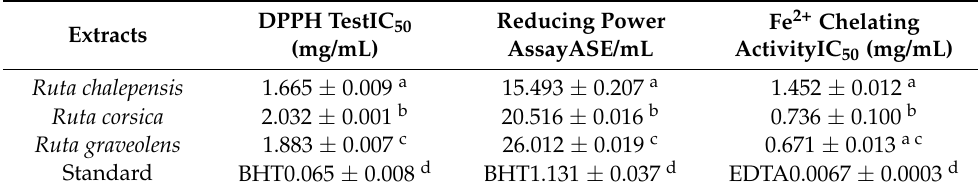
Figure 4. Free radical scavenging activity of the methanolic extracts of the Ruta spp. in vitro cultured biomass. Values are expressed as the mean ± SD ( n = 3). Table 2. Free radical scavenging activity (DPPH test), reducing power, and ferrous ions (Fe 2+ ) chelating activity of the methanolic extracts of the Ruta spp. in vitro cultured biomass.